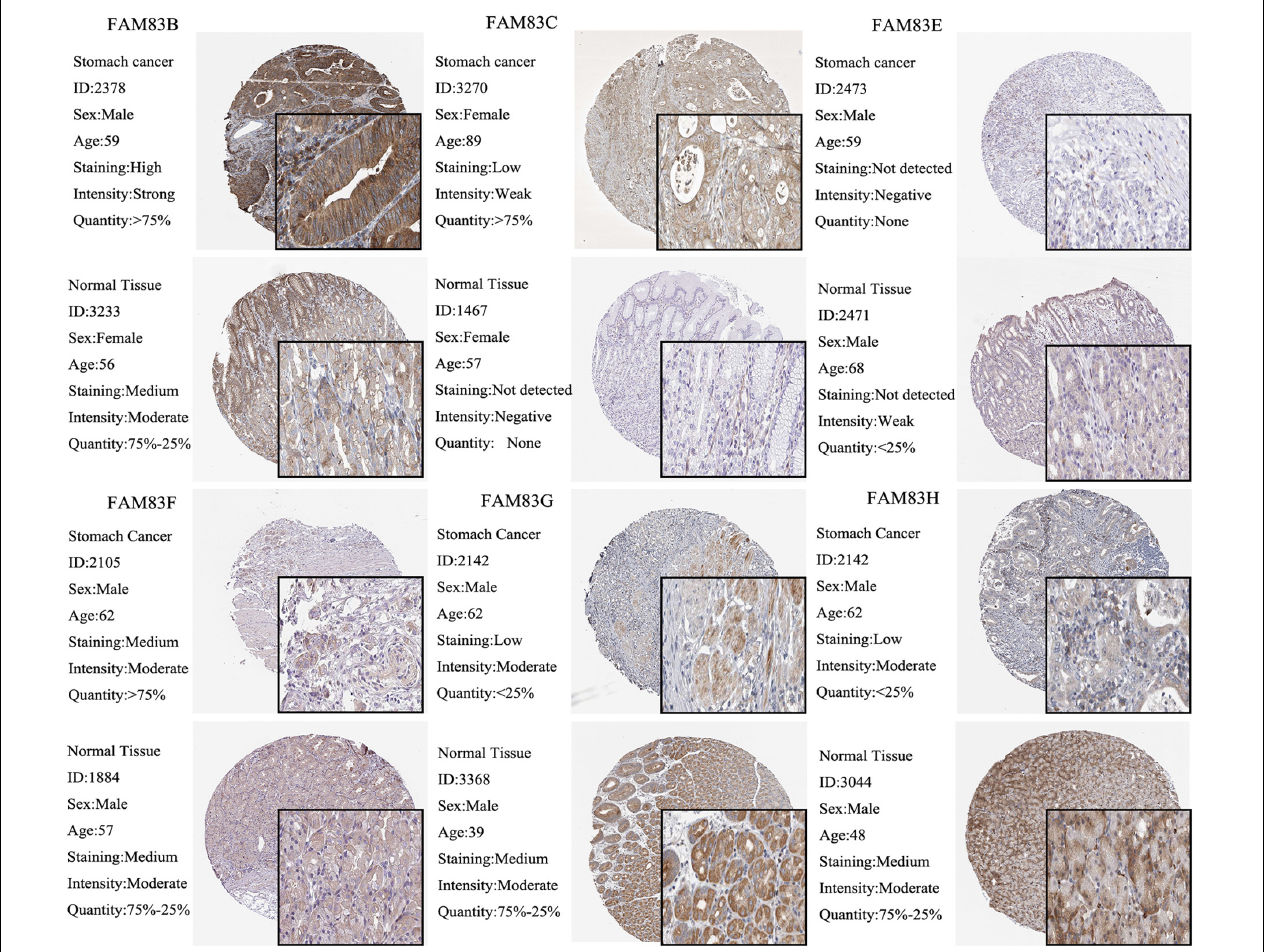
FIGURE 3 | The IHC analysis of FAM83 family with prognostic values. Differentially expressed proteins of FAM83 family members with prognostic values in STAD and normal stomach tissues in The Human Protein Atlas